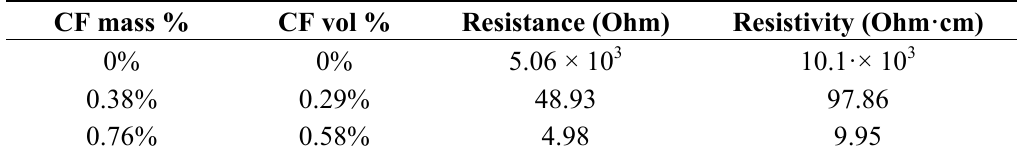
Table 2. Electrical resistance and resistivity values for different carbon fibers (CF) dosage by BFS